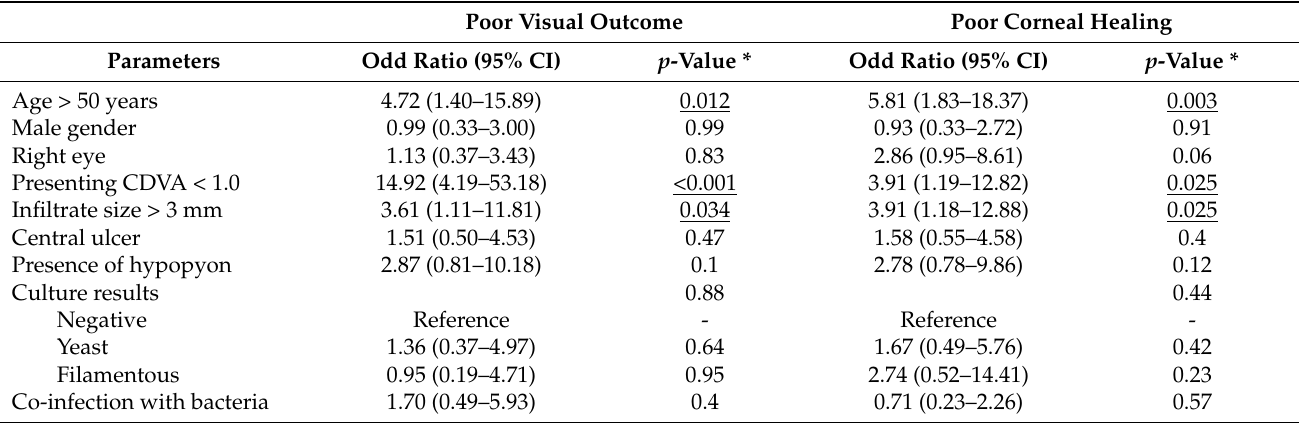
Figure 2. Comparison of corrected-distance-visual-acuity (CDVA) at initial presentation and final follow-up. Table 5. Prognostic factors for poor visual outcome [defined as corrected-distance-visual-acuity (CDVA) of <1.0 logMAR]. and poor corneal healing (defined as >60 days to achieve complete healing or required tectonic/therapeutic keratoplasty, evisceration or enucleation) in fungal keratitis in the